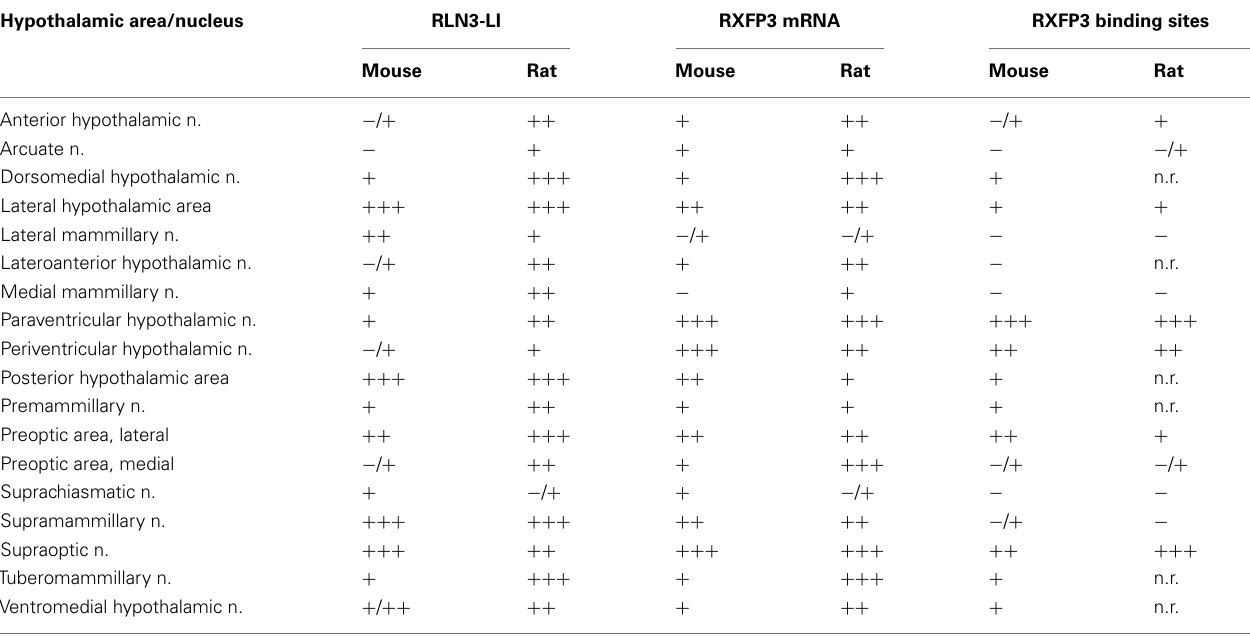
Table 1 | Comparative distribution of relaxin-3 and its receptor, RXFP3, in hypothalamic regions of rat and mouse brain. Hypothalamic area/nucleus